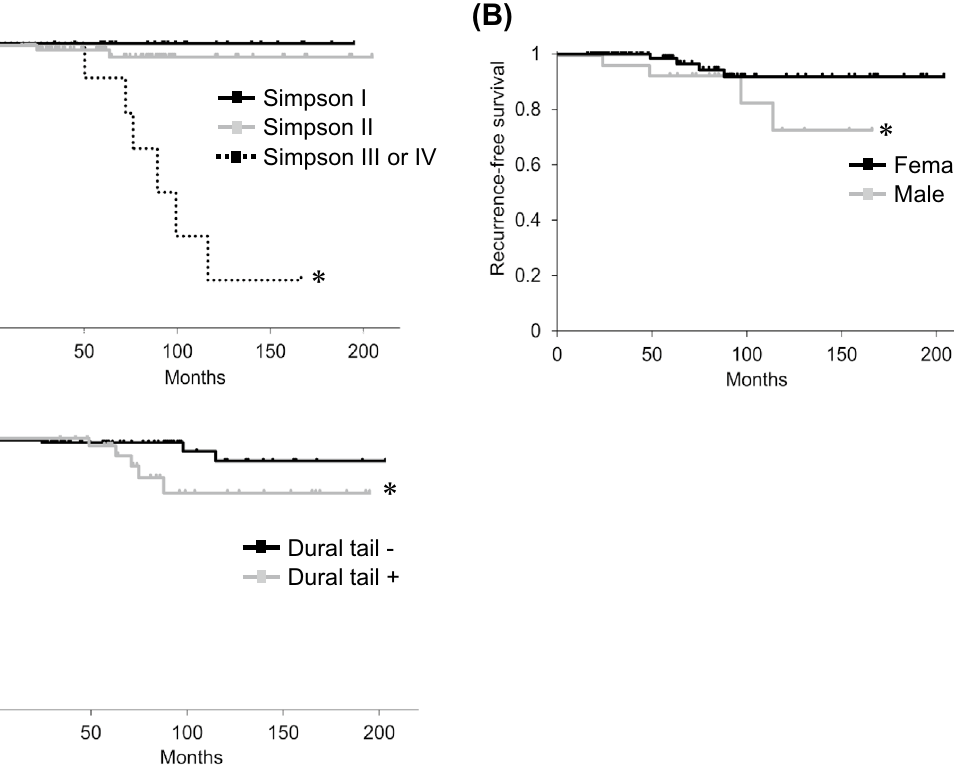
Figure 6. Kaplan–Meier survival curves. Probability of recurrence for ( A ) Simpson grade (I vs. III or IV, P < 0.05; II vs. III or IV, P < 0.05), ( B ) gender (male vs. female; P < 0.05), ( C ) dural tail (dural tail+ vs. dural tail−; P < 0.05). *P <